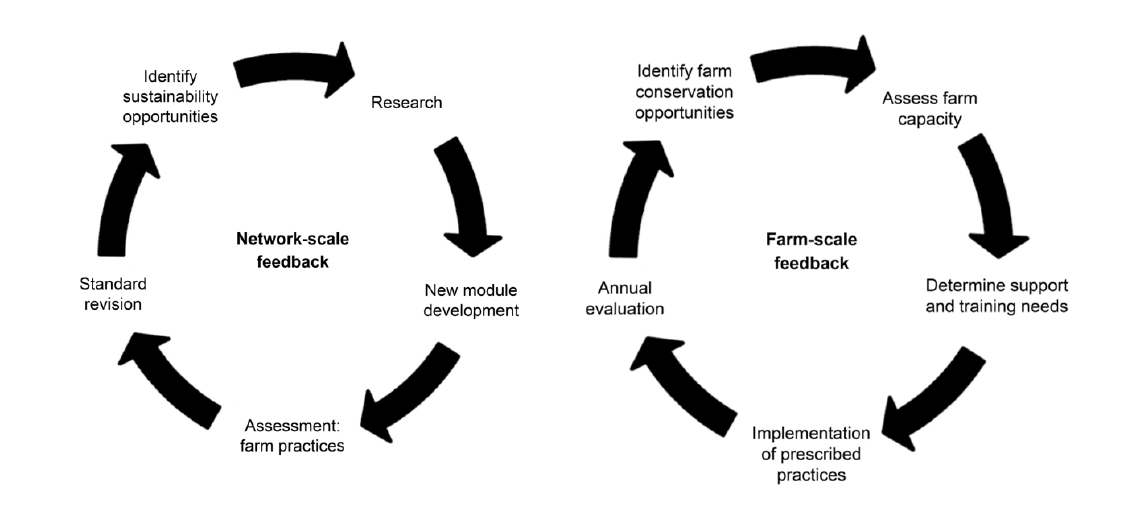
Fig. 3 . Positive feedbacks for building network and farm stewardship capacity. The network-scale feedback (left) is used to advance the agricultural productions standard through a continual process of review and response to issues of regional sustainability. The farm-scale feedback (right) advances the stewardship capacity of enrolled producers through a conservation planning process that is responsive to the circumstances of each